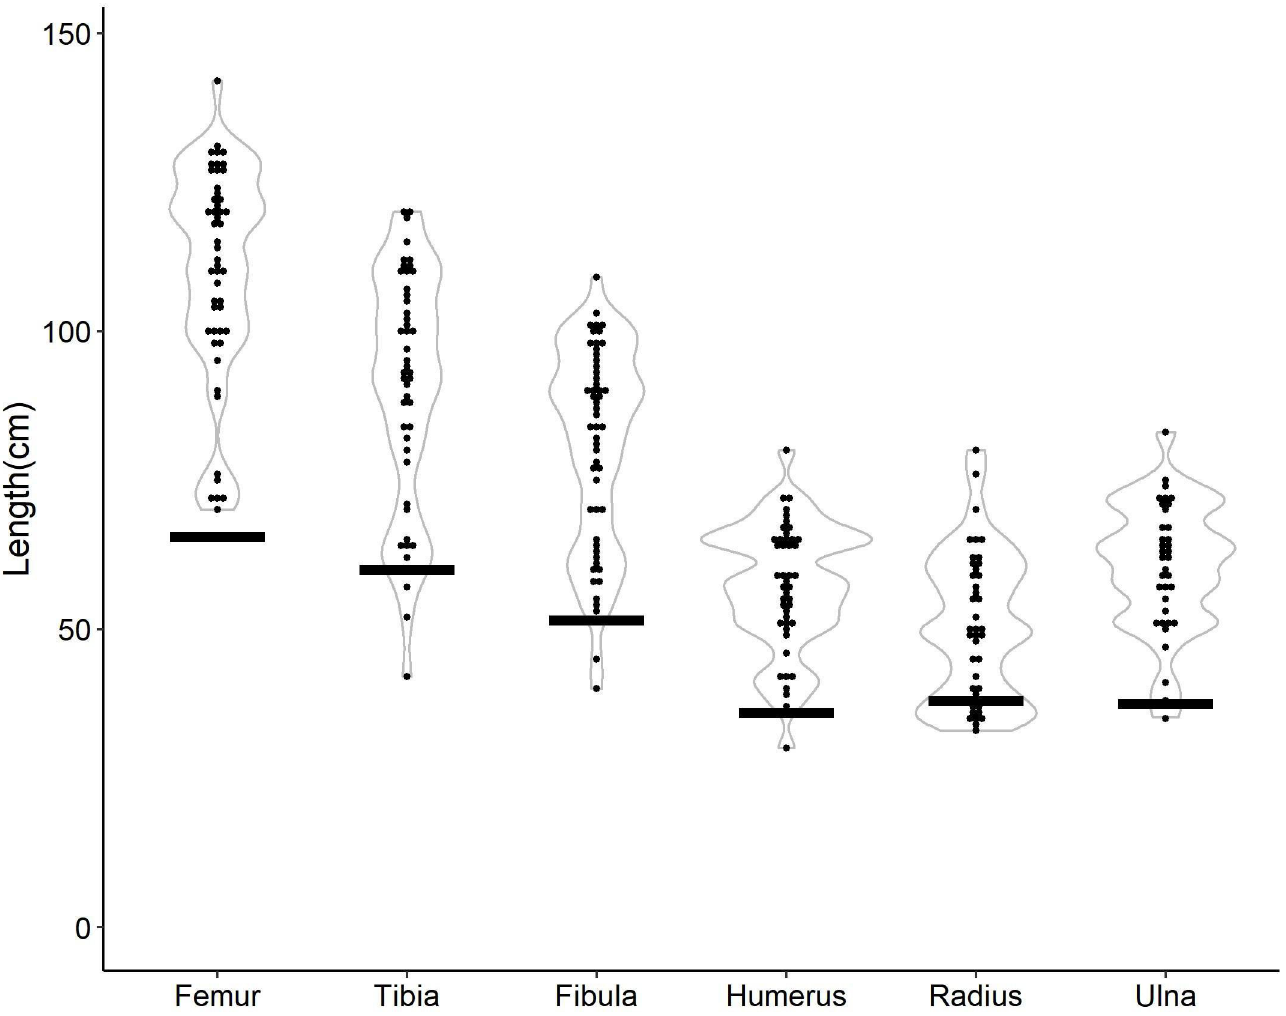
Fig 9. Lengths of major long bones. Dark black bars denote the size of a bone 50% the average length of the three longest specimens for each bone type (after the longest “outlier” is removed for each bone type [all categories except tibia]). (T). The vast majority of bones show no weathering (98.5%). Data from teeth and ossified ten-